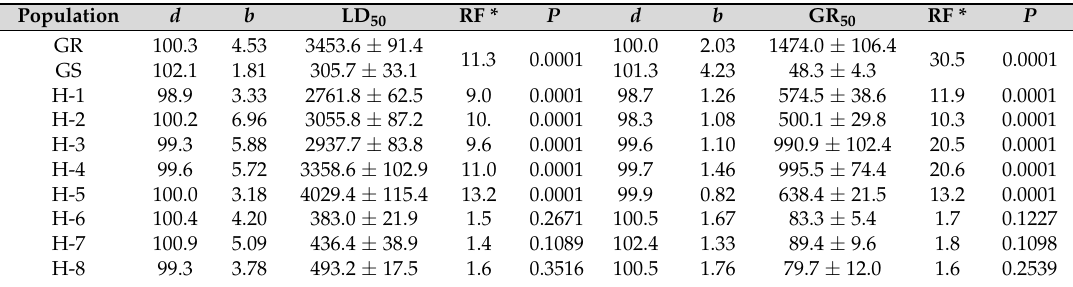
Table 3. Parameters of the log-logistic equations a used to calculate the glyphosate rates (g ea ha − 1 ) required for 50% survival (LD 50 ), or reduction fresh weight (GR 50 ) of C. canadensis populations from Spain (GR and GS) and Hungary